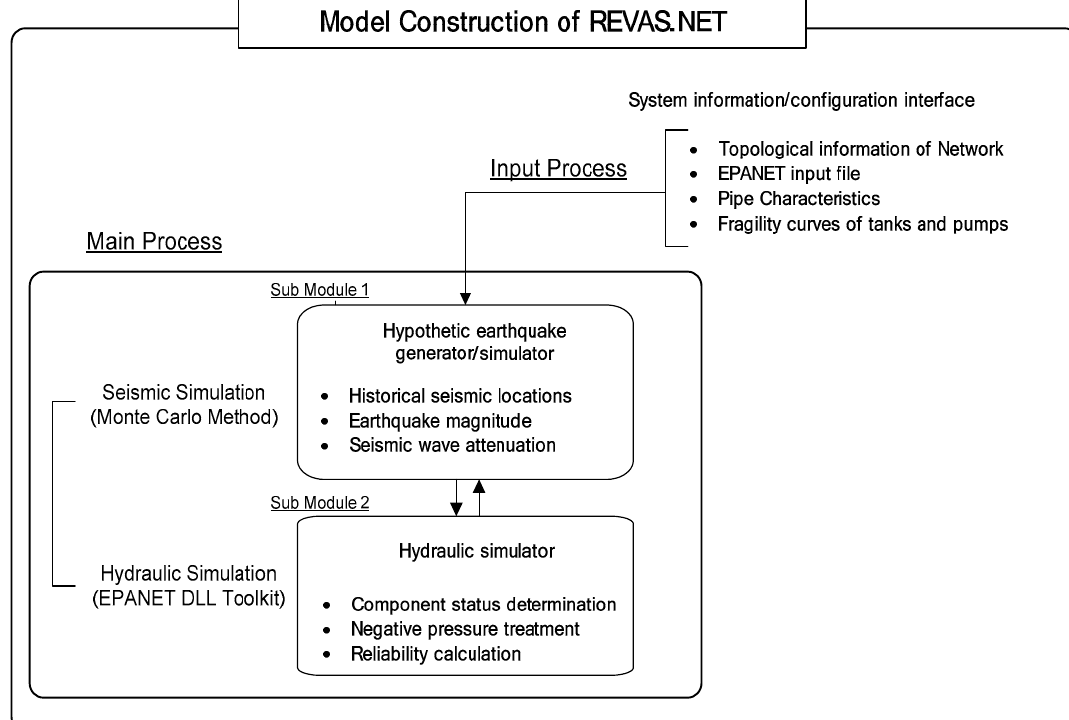
Table 2. Appropriate analysis techniques according to the purposes of pipe network analysis.